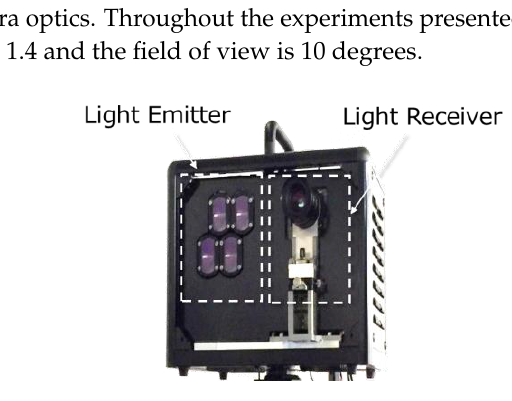
Figure 12. A photograph of a developed prototype TOF camera. As described in the inset, the left side is light emitter part and the right side is the receiver or CIS part.